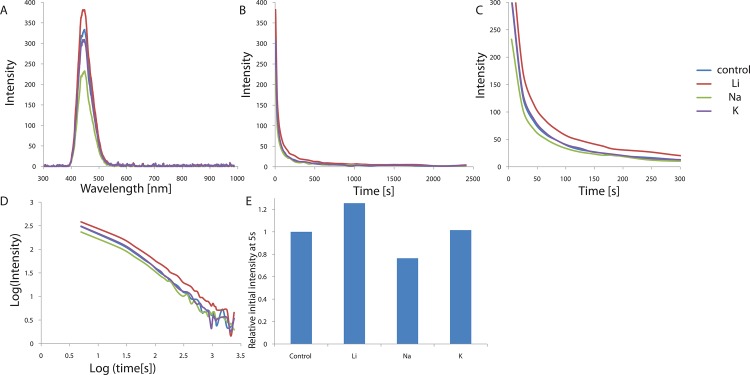
(A) Emission spectrum of CaAl2O4:Eu2+, Nd3+ crystals depending on alkali metal ion doping. (B) Decay curves depending on alkali metal ion doping. (C) Magnified views of the graph in (B). (D) Decay curves in log scale depending on alkali metal ion doping. (E) Relative initial intensity measured at 5s (relative values where the value of control sample is 1.0) depending on alkali metal ion doping.